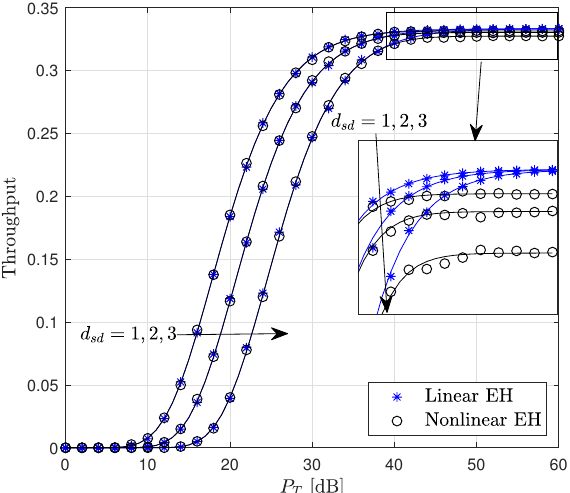
Figure 8. Throughput performance of the WP DH AF relaying system versus P T ( R = 1 bits/s/Hz, P th = 35